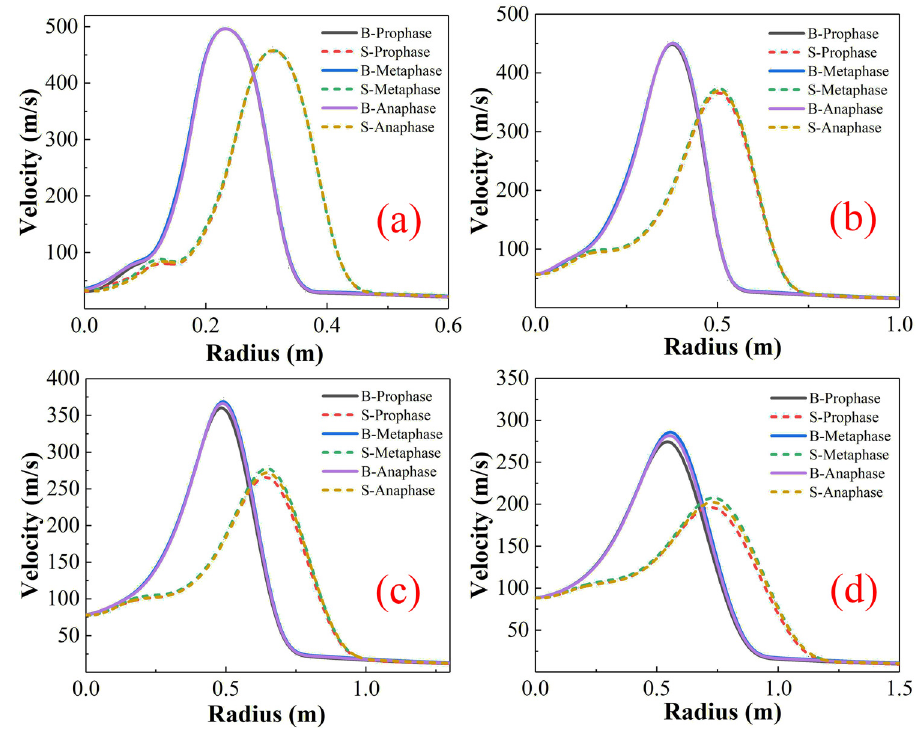
Figure 11: Radial velocity distribution of the jet under di ff erent atmospheric conditions: ( a ) 600 mm, ( b ) 1,300 mm, ( c ) 2,000 mm, and ( d ) 2,700 mm.